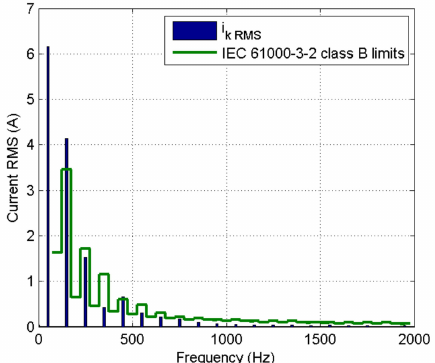
Figure 12. Testing for harmonic current emissions. RMS values of harmonic components of the current drawn by the tested drive for the motor loaded with the full rated torque at n = 10,000 rpm and for the PWM duty cycle of 81%. Two chokes of 0.68-mH inductance are placed on the L and N lines, respectively, between the input EMC filter and the Graetz bridge rectifier. This modification did not improve the standard